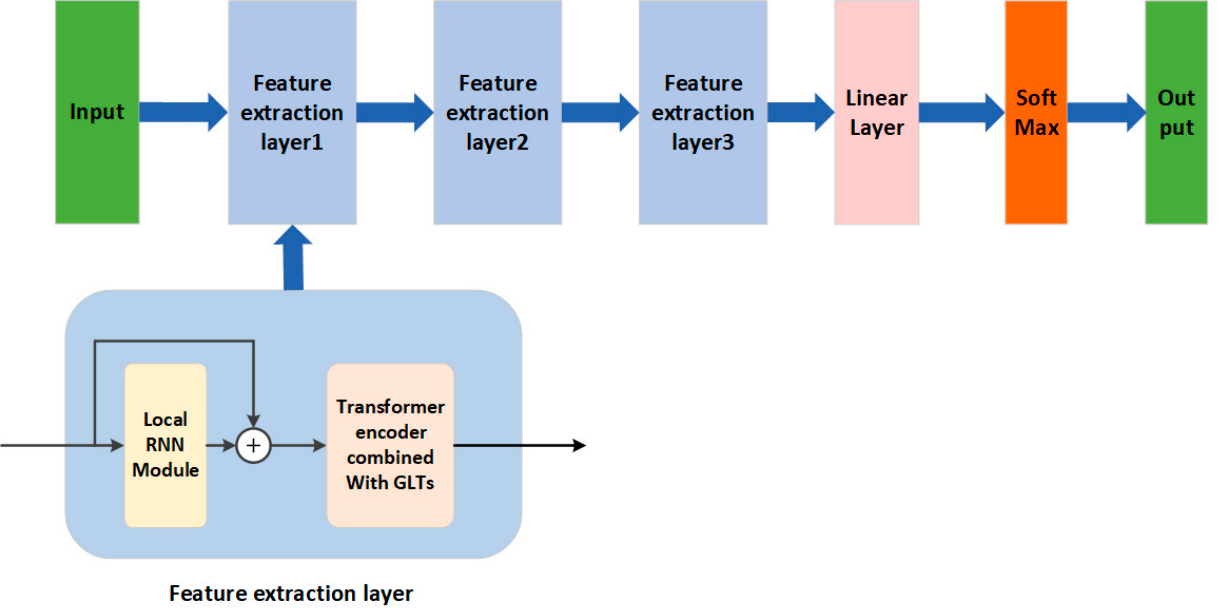
Figure 1. Lightweight Transformer model structure. The feature extraction module consists of a local RNN module and a Transformer encoder modified by GLTs. The classifier consists of a linear layer and a SoftMax function.